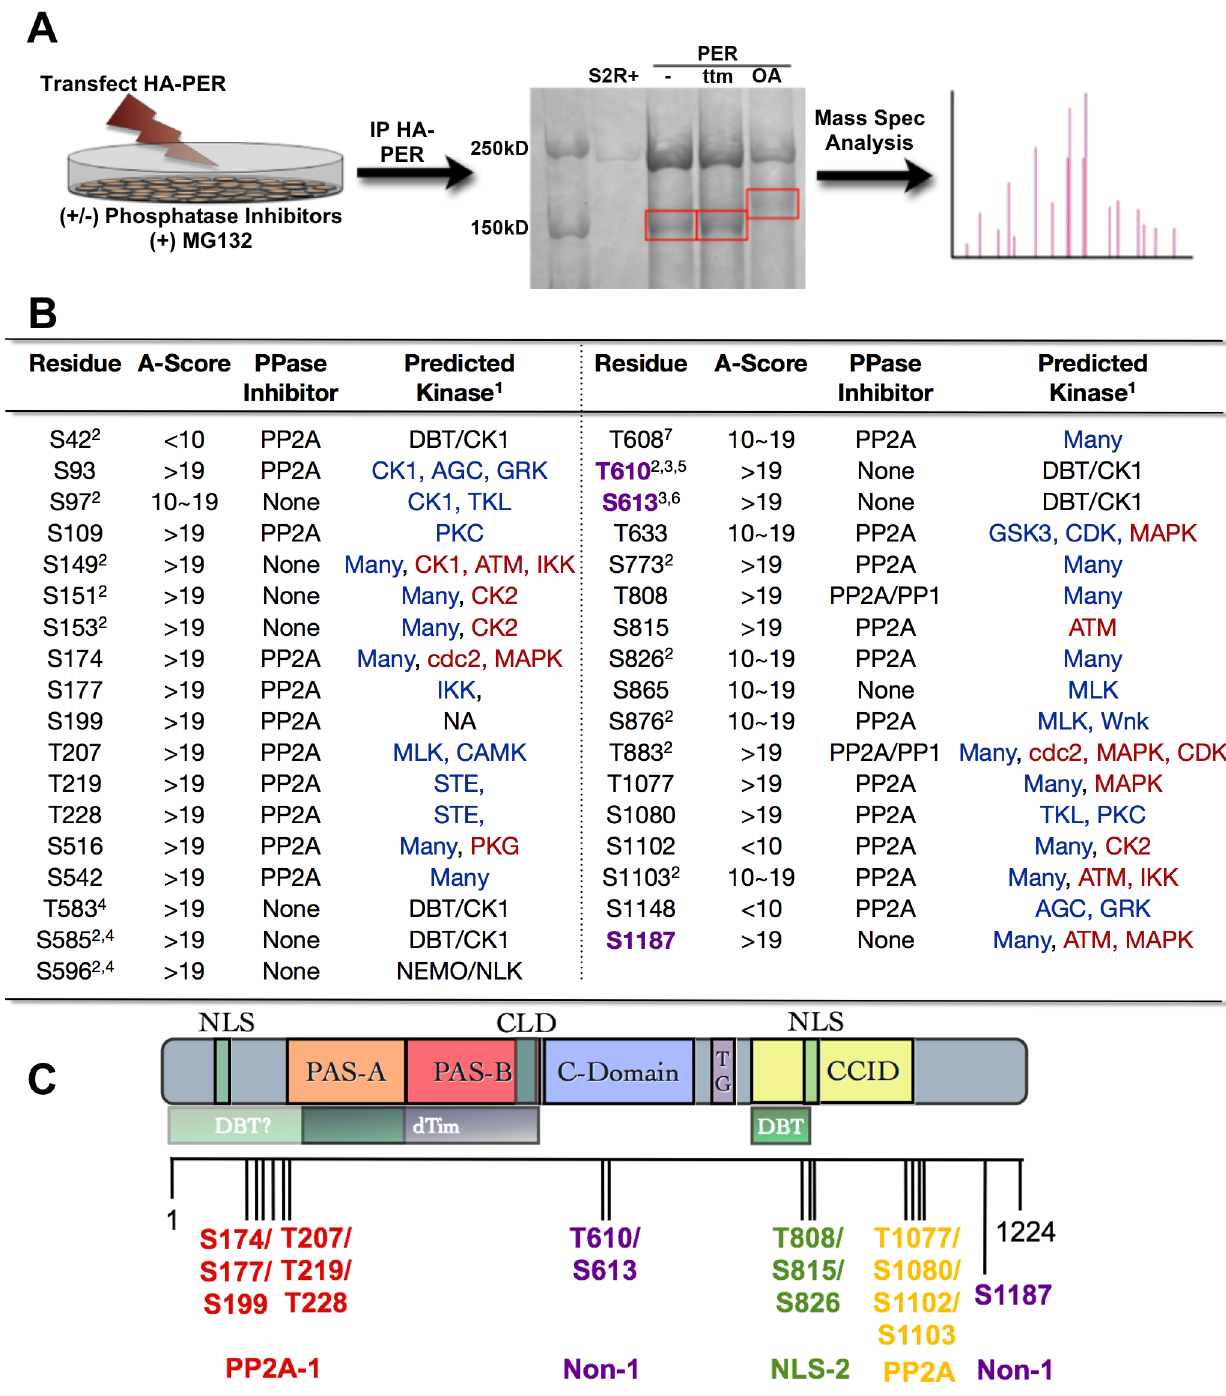
Figure 1. PER phosphorylation sites mapped by mass spectrometry. ( A ) Diagram depicting mass spectrometry experimental approach. See Material and Methods for additional details. ( B ) Table of phosphorylated residues of PER identified in this study. The exact phosphorylation sites are shown as serine (S) or threonine (T) followed by the number of their position in the PER protein sequence (1–1224, Accession # P07663). AScore was determined as described in Beausoleil,S.A. 2006 [29]. In general, phosphorylation sites detected by mass spec with an AScore . 19 are almost certain; with 10 , AScore , 19 are probable; with AScore , 10, are detected but uncertain. PPase inhibitor indicates whether a residue is naturally phosphorylated in S2R + cells (None), or is phosphorylated only when treated with PP1 and/or PP2A inhibitors. 1=The GPS (blue text; high threshold) and KinasePhos (red text; 100% specificity) online databases were used to predict kinase activity except where noted; 2=Chiu et al., 2008; 3=Kivimae et al., 2008; 4=Chiu et al., 2011; 5=Additional predictions: KinasePhos=cdc2, MAPK, CDK. Many other kinases were predicted to phosphorylate T610 by GPS; 6=Additional predictions: GPS=AGC; KinasePhos=MAPK at 90% specificity; 7=Note, S607 was identified to be a DBT substrate in Kivimae et al., 2008. Abbreviations: MLK=Mixed Lineage Kinase; TKL=Toll Kinase-Like; GRK=GPCR Kinase; AGC=PKA/G/C Kinase Group ( C ) Schematic representation of PER including functional domains and grouped phosphorylation sites (adapted from [32], with updates from [26,33]). The nuclear localization signal (NLS), two PER-ARNT-SIM (PAS) domains (PAS-A and PAS-B), the cellular localization domain (CLD), the conserved C-domain, the